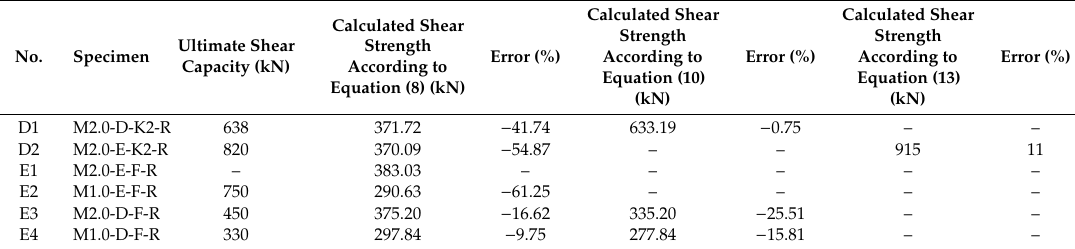
Table 3. Shear capacity of joints with dowel